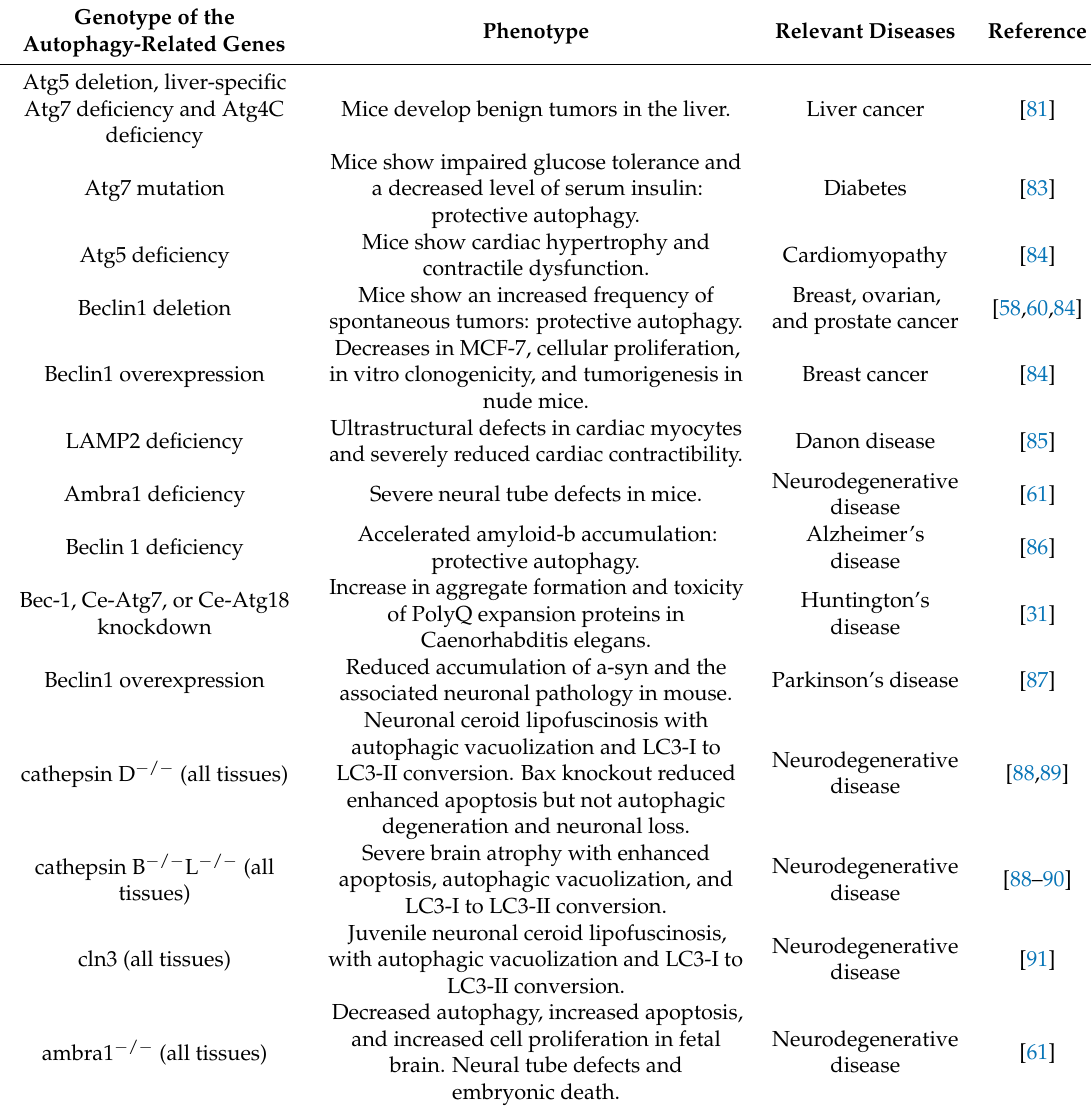
Table 1. The phenotypes and diseases associated with an alteration of the autophagy